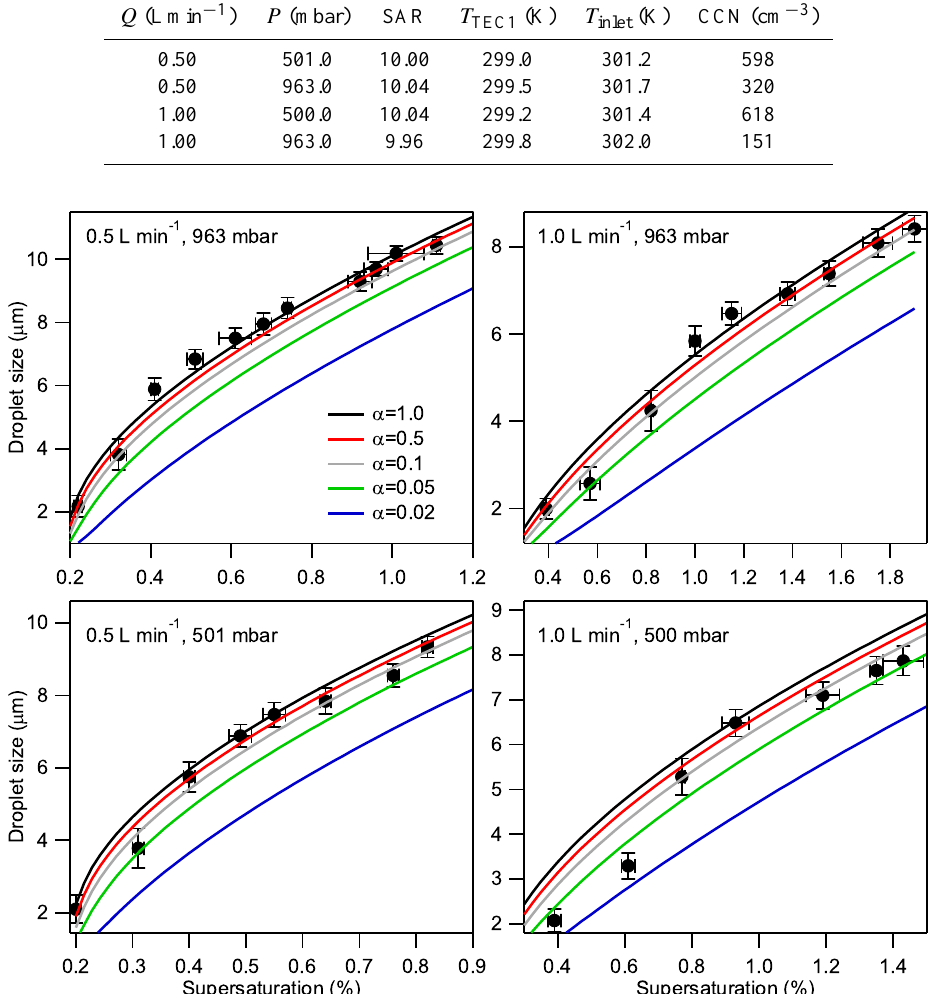
Fig. 5. Observed and predicted droplet size for 90nm ammonium sulfate particles. Model predictions are from the constant velocity model when using different water vapor uptake coefficients. Supersaturation error bars are based on uncertainties of the calibrated supersaturations and droplet size error bars are the average distribution widths described by standard